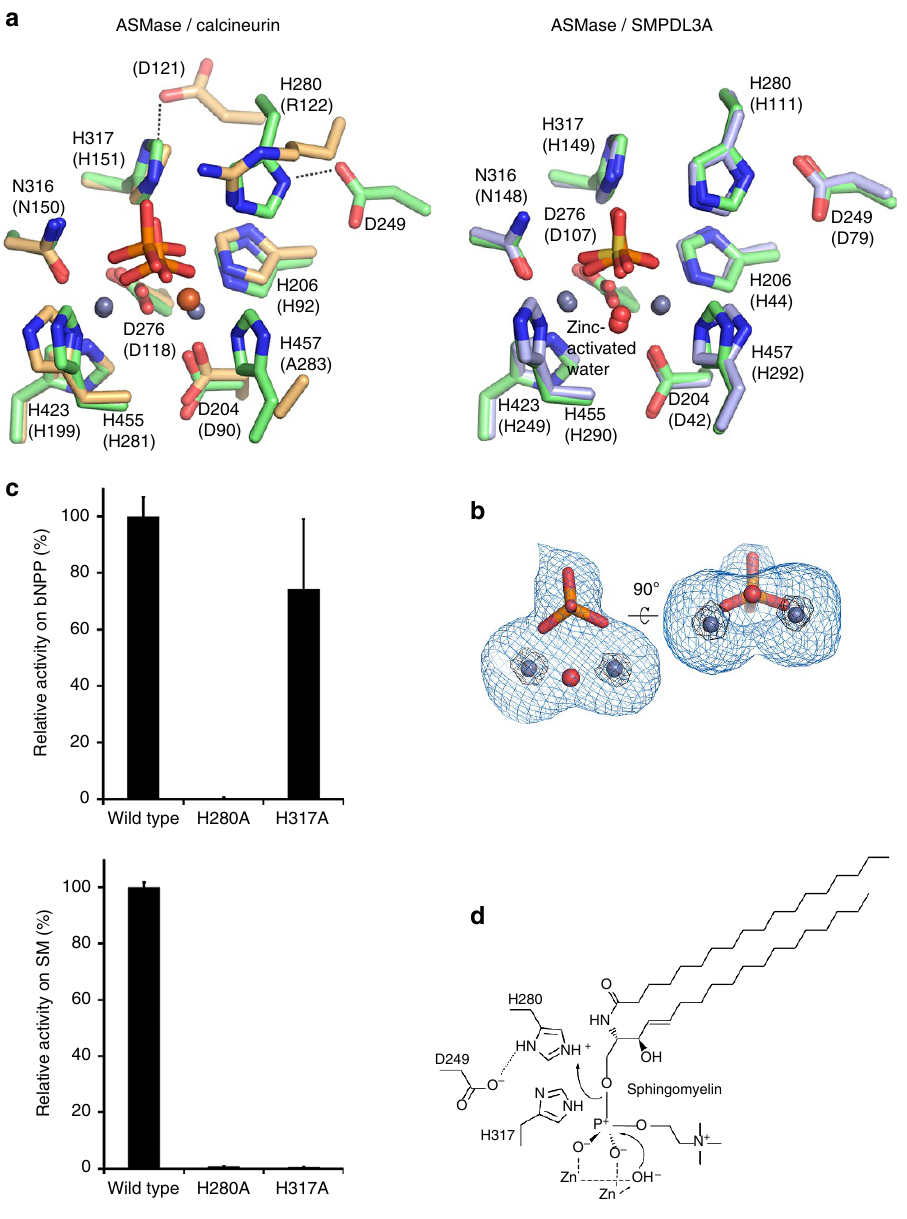
Figure 3 | Comparison and mutation of the ASMase active site and proposed catalytic mechanism. ( a ) Active site of ASMase (green) is superimposed with that of calcineurin (PDB code 3LL8, beige) or SMPDL3A (PDB code 5FC1, blue). The active sites are very well conserved and likely use a similar mechanism of catalysis. However, there are slight differences. For example, in calcineurin the His–Asp proton-donating pair actually corresponds to His317 in ASMase, which is more likely involved in substrate binding. In addition, the His280 proton donor position is replaced with an arginine residue in calcineurin. ( b ) Electron density map around the zinc ions (blue spheres), bound phosphate and nucleophilic water (red sphere). Shown is an F o –F c simulated annealing omit map contoured at 3 s (blue mesh) and 25 s (black mesh). The zinc-activated nucleophilic water molecule, which is part of the zinc octahedral coordination shell, could not be resolved separately in the electron density because of the resolution limit (2.6Å). Thus, we based its position on the much higher resolution structure of SMPDL3A (PDB code 5FC1, 1.4Å). ( c ) Top: substitution of His280 with alanine completely inactivates the enzyme, while the His317 to alanine substitution only slightly reduces activity against the non-lipid substrate bNPP. In absolute numbers, the activity of the wild-type enzyme is 1.76 m M bNPP hydrolyzed per nM protein per h. Data are the means and s.d.’s of two to five experiments performed in triplicates. Bottom: by contrast, using liposomes as substrate instead of bNPP, both His280 and His317 mutants abrogate enzymatic activity, suggesting that His317 is also important, probably for substrate binding or orientation. ( d ) The catalytic mechanism involves a nucleophilic attack by a zinc-activated water molecule on the phosphate group of sphingomyelin. This is followed by protonation of the ceramide leaving group by His280 with assistance from Asp249 and release of ceramide and molecules bound within it (Supplementary Fig. 3b). In addition, the top edge of helix a 2, which is lined with a ridge of positively charged residues, is appropriate for interaction with anionic intra-lysosomal vesicles 21 (Fig. 6a). Consistent with this, mutation